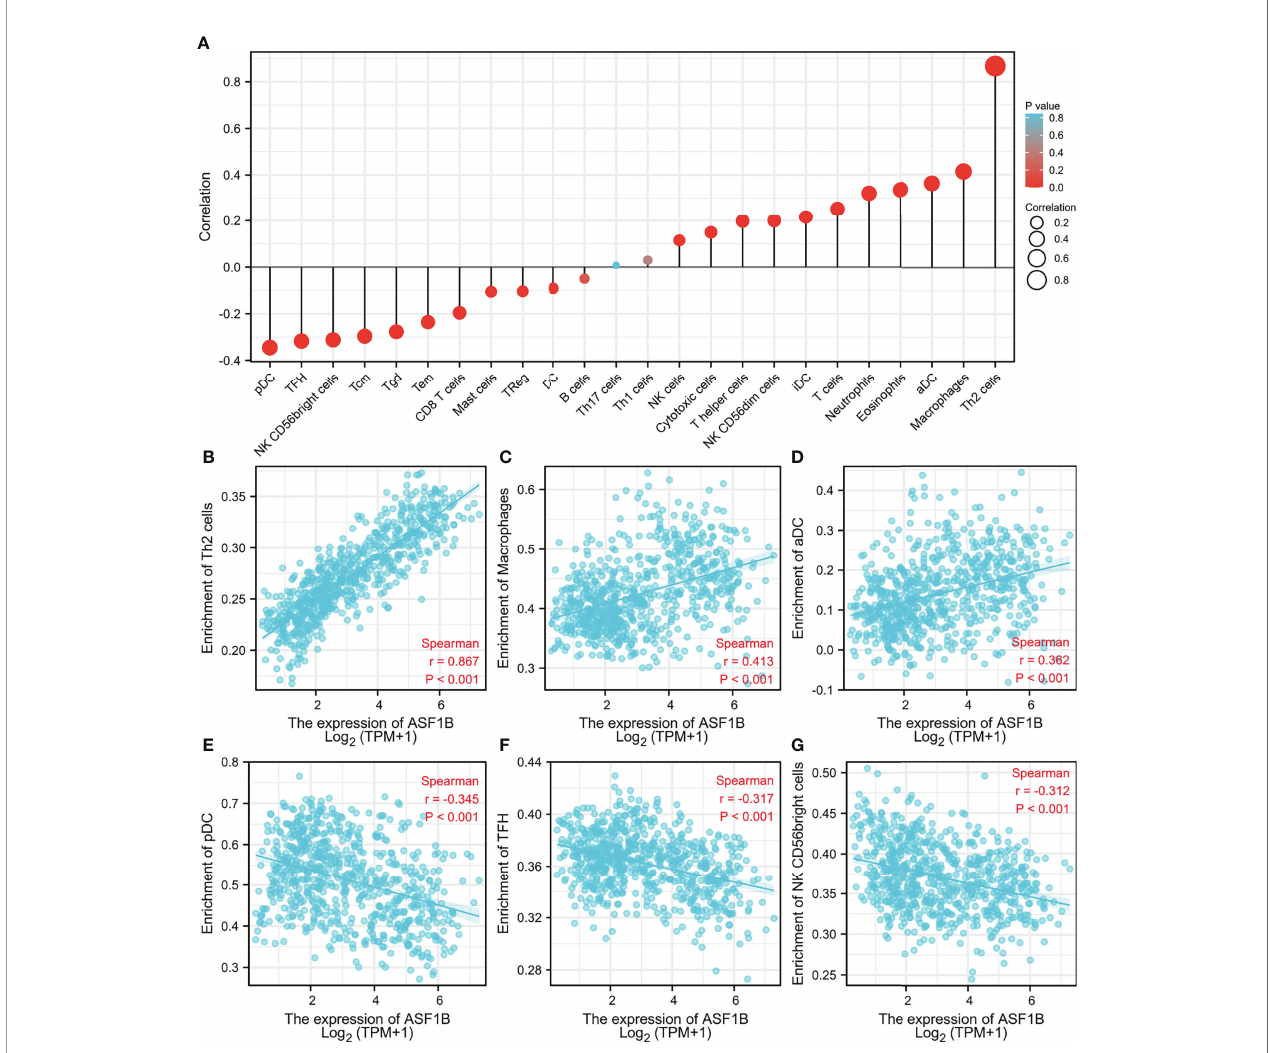
FIGURE 7 | Association analysis of ASF1B expression and immune in fi ltration in glioma patients. (A) The association between ASF1B expression and 24 tumor- in fi ltrating lymphocytes. (B – D) The positive correlation of ASF1B expression with immune in fi ltration level of Th2 cells (B) , macrophages (C) , and aDC (D) . (E – G) The negative correlation of ASF1B expression with immune in fi ltration level of pDC cells (E) , TFH (F) , and NK CD56 bright cells (G)